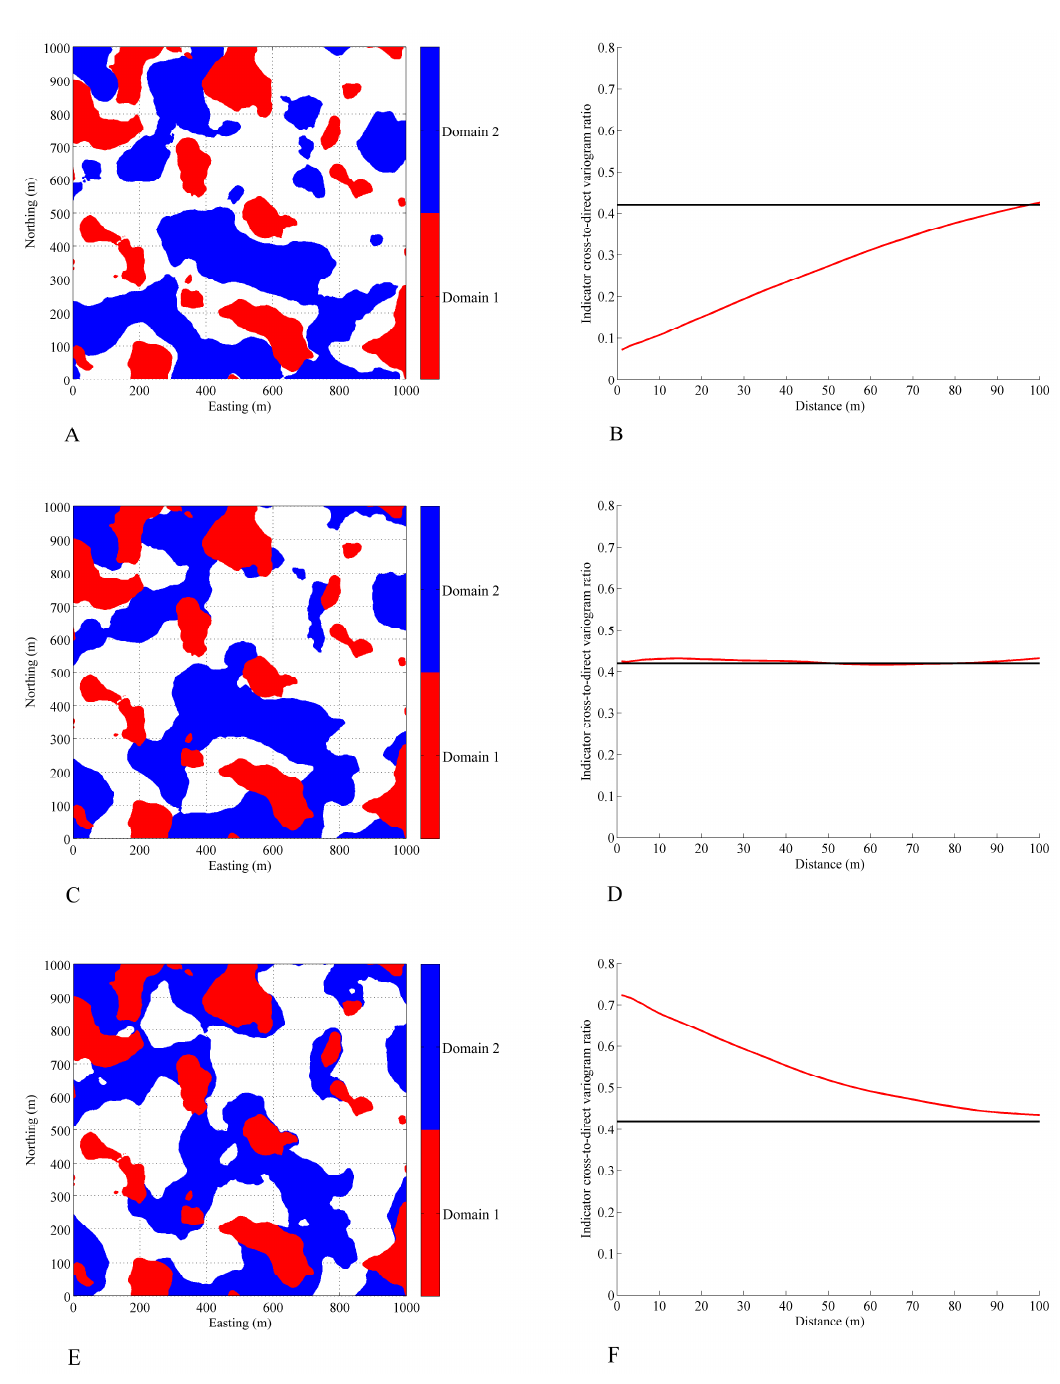
Figure 4. Plan views of geological domains ( A , C , E ) and absolute values of the ratios of indicator cross-to-direct variograms − γ 1,2 / γ 1 (red curves) ( B , D , F ); the expected sill value (Equation (20)) is represented by a black solid line.